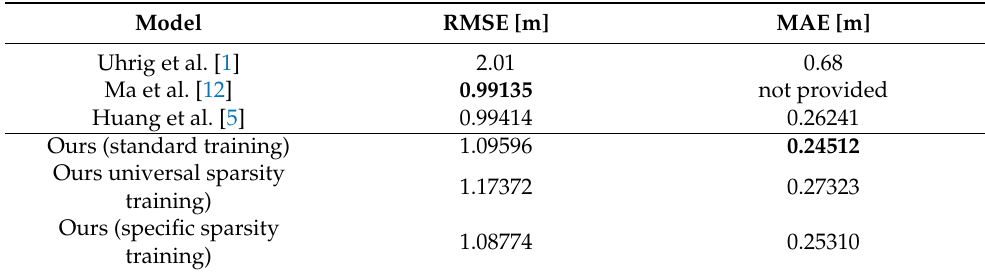
Table 2. Performance of the unguided depth completion methods on the KITTI validation